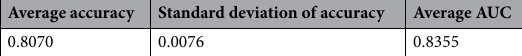
Average accuracy Standard deviation of accuracy